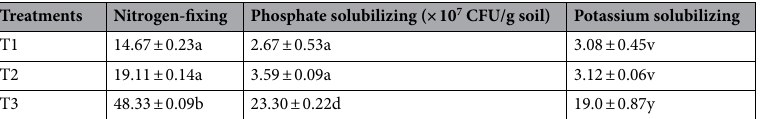
Table 2. Showing the changes in beneficial bacterial population in crude oil contaminated soil after 60 days of experimental trials employing Cyperus brevifolius. Mean value ± SD, n = 3; the different letters within the same column represent the significant differences of the values (ANOVA, LSD test, P < 0.05 ). T1- Crude oil contaminated soil (Initial); T2- Crude oil contaminated soil without Cyperus brevifolius ; T3- Crude oil contaminated soil + Cyperus brevifolius.